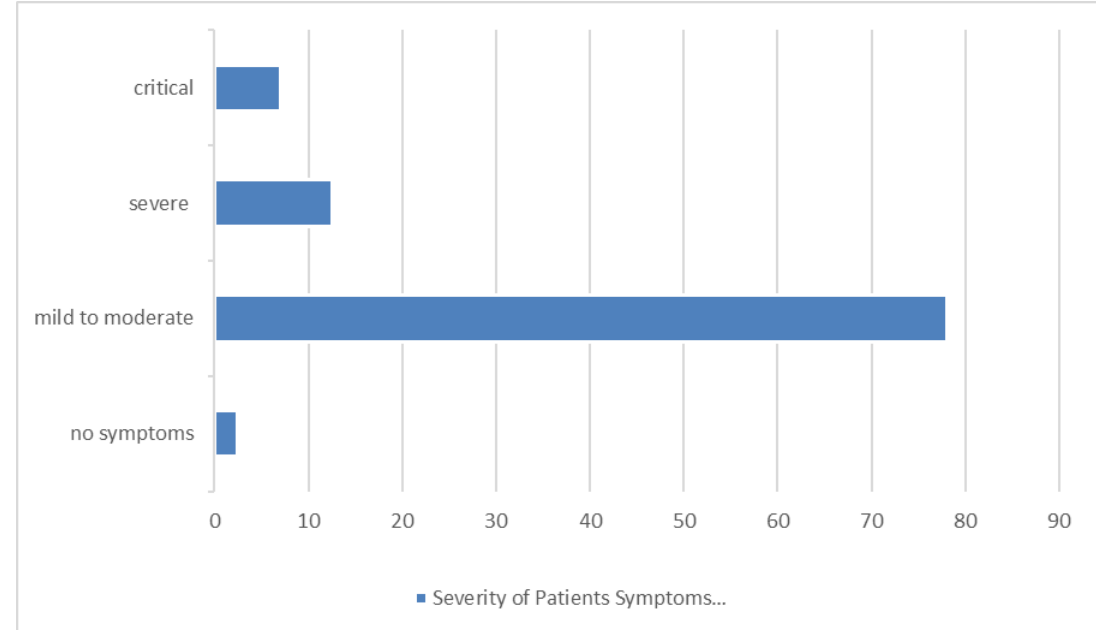
Figure 1. Severity of patients’ symptoms. Pharmacological protocols used by patients are shown in Table-2. Different therapies were used and all of them included vitamin D3. Other